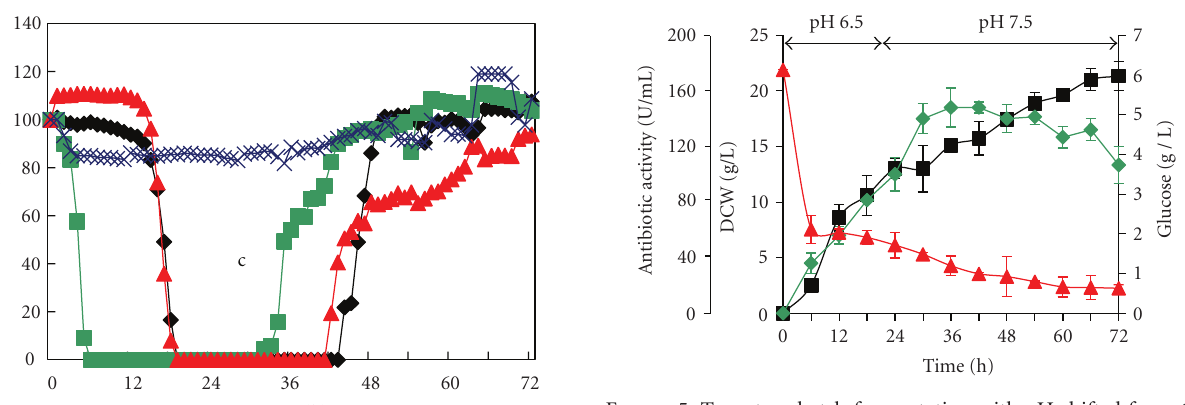
Figure 4: The variation in dissolved oxygen concentration with the cultivation time. pH 4.5 ( 9.5 ( × ).